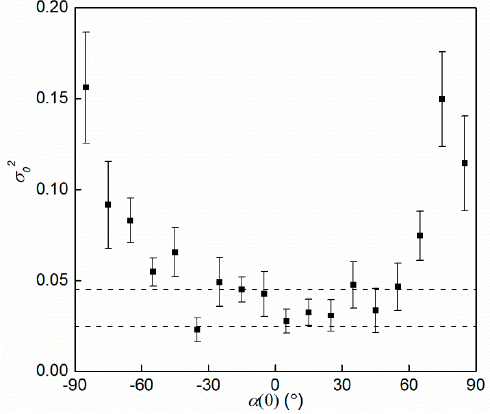
Figure 16. D r at different initial swimming angles.